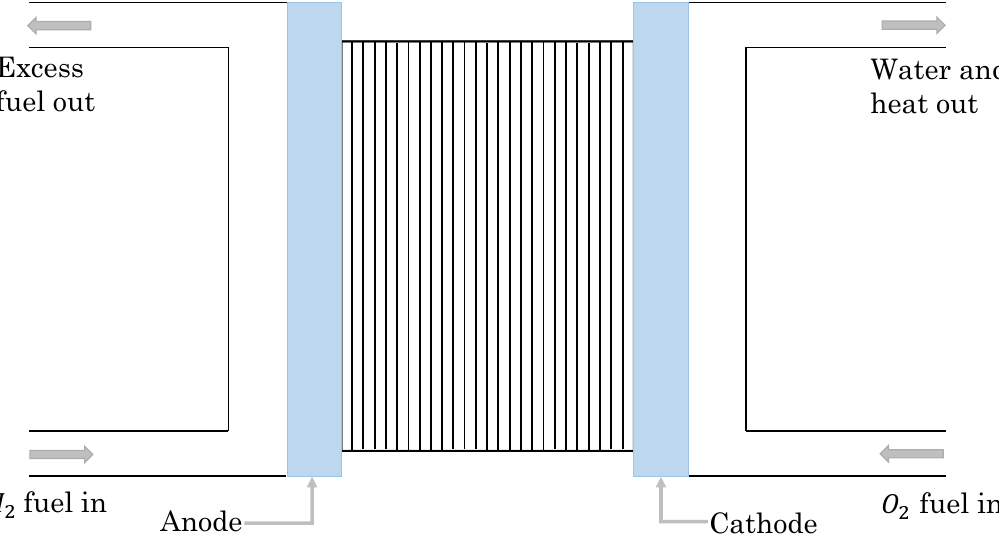
Figure 1. Simplified diagram of a proton-exchange membrane fuel cells (PEMFC). The proton-exchange membrane is located between the anode and